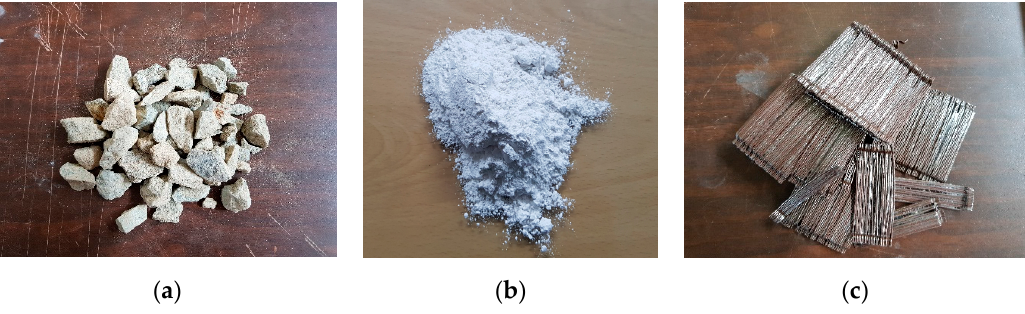
Figure 4. Selected bridging materials: ( a ) crushed aggregate; ( b ) retarder; and ( c ) steel fiber.